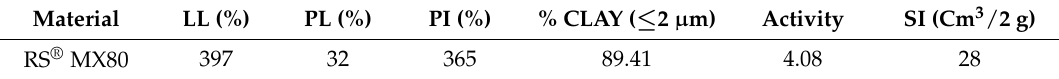
Table 4. Geotechnical measurements for unaltered MX-80.